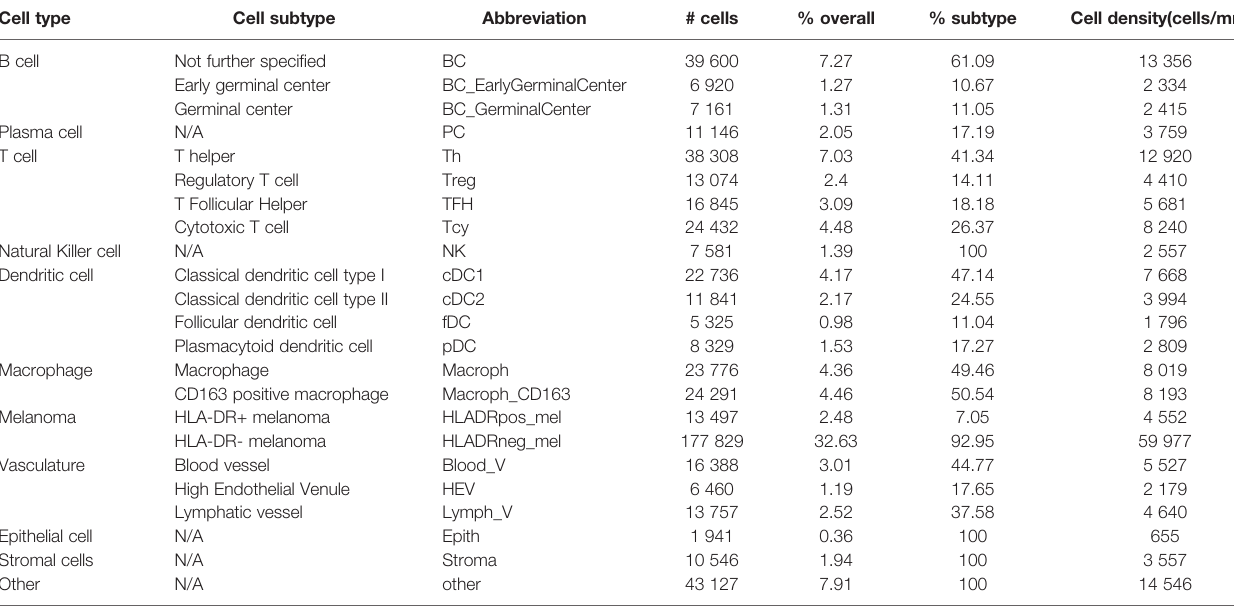
TABLE 1 | Main cell types identi fi ed with